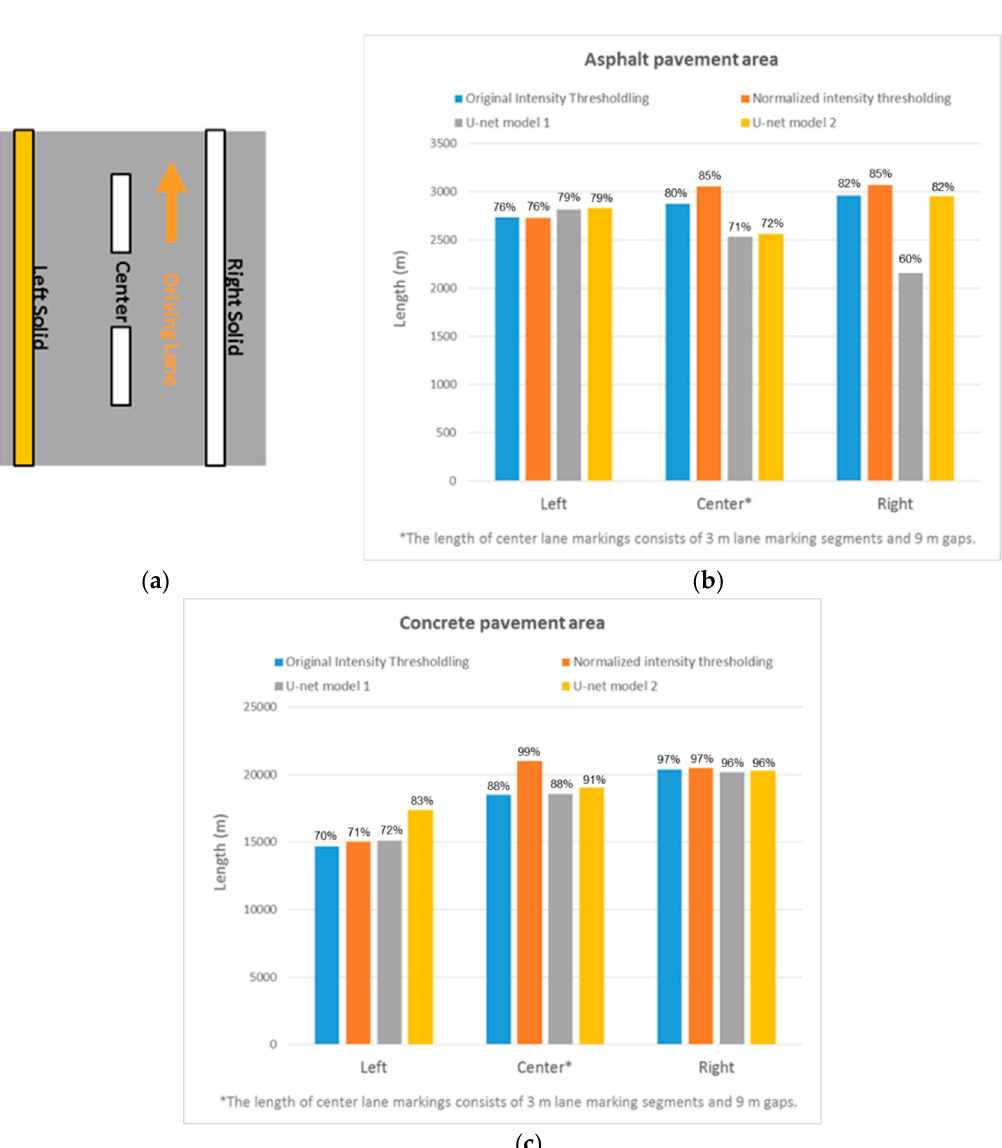
Figure 27. Illustrations of ( a ) lane marking schematic diagram and length of lane markings extracted from different strategies in ( b ) asphalt pavement areas and ( c ) concrete pavement areas for dataset 3.